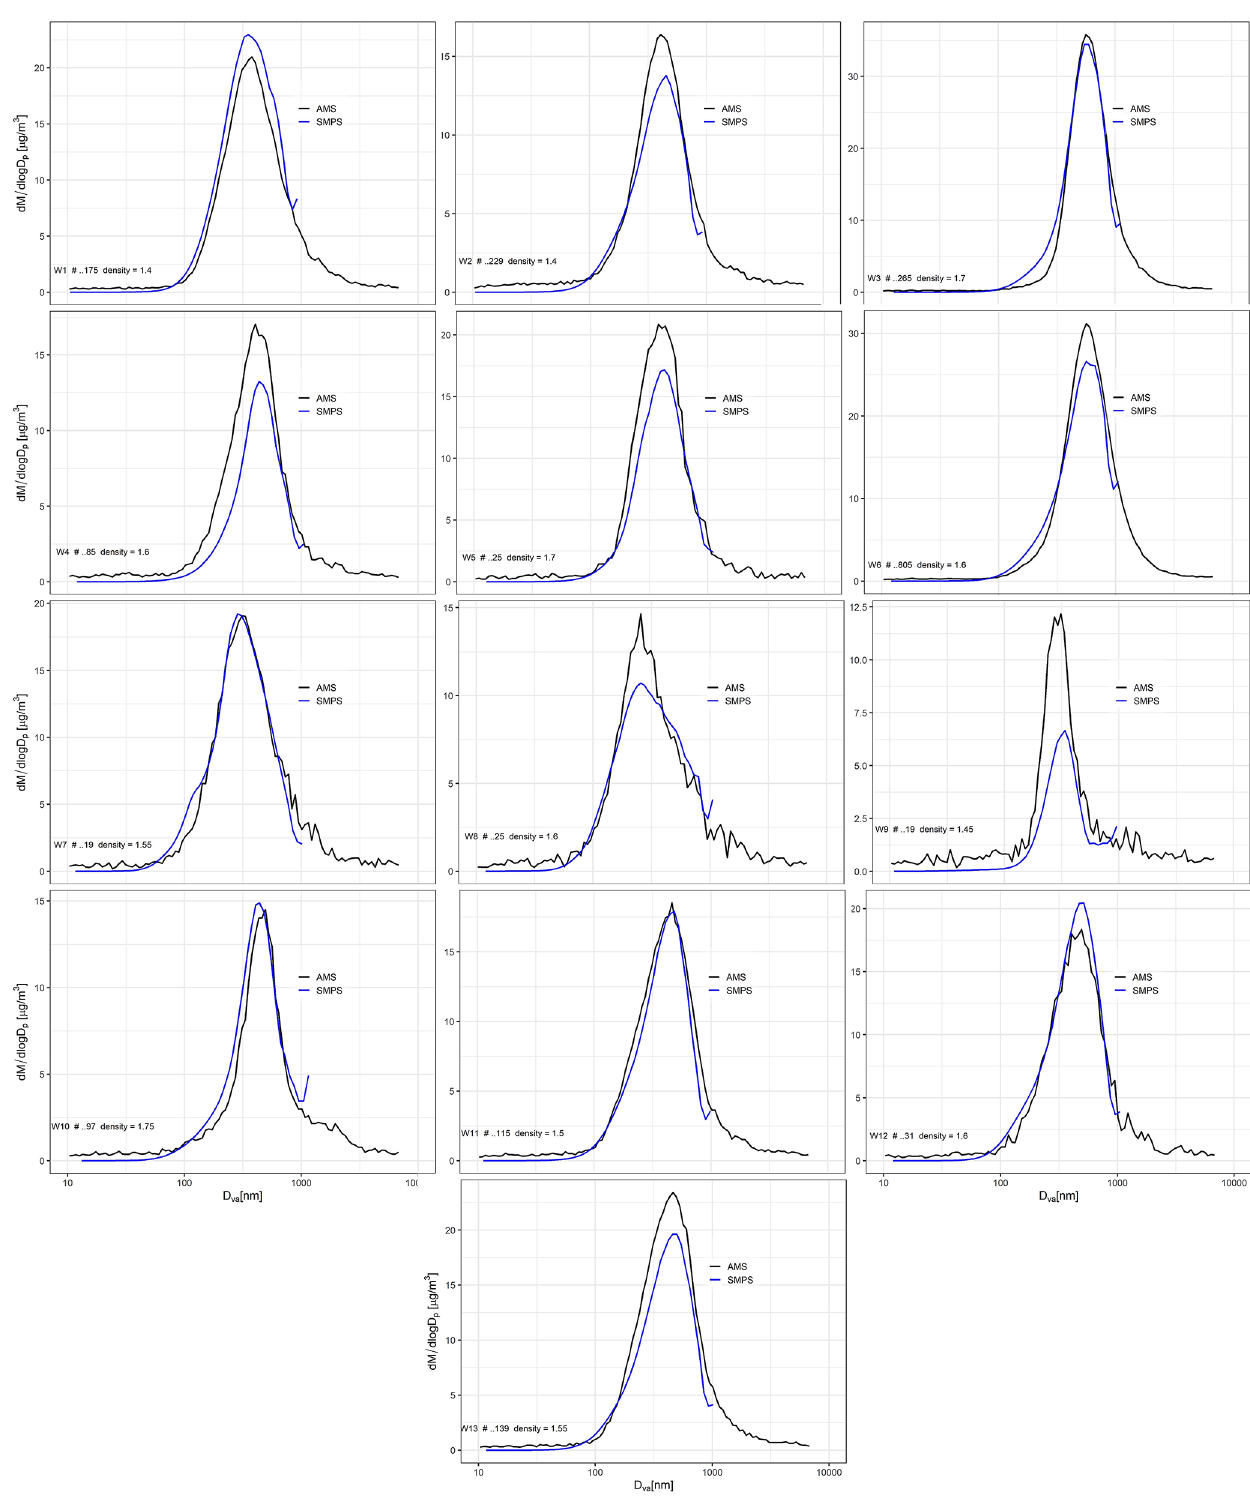
Figure A10. Fit of AMS and MPSS mass size distribution spectra of winter episodes (W1–W13) for density calculation.